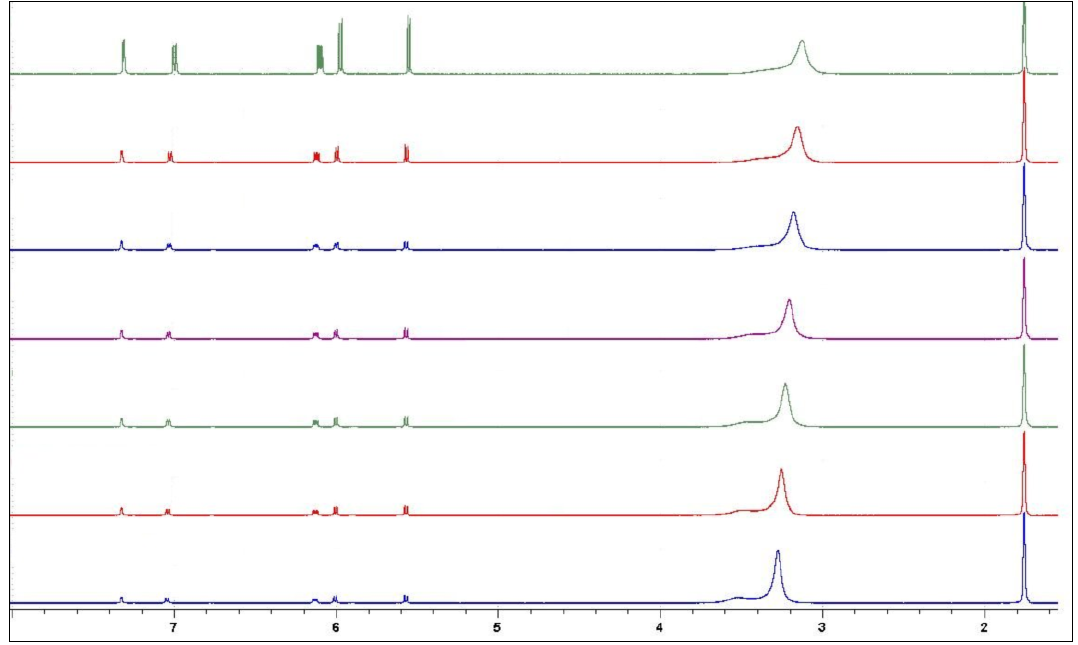
Figure 6. Variable temperature 500 MHz 1 H-NMR spectra of 1.0% 5-chloro-8-hydroxy- quinoline in CD OD/D O (2:1) from +18 °C (bottom) to +30 °C (top) in 2 °C steps. The 3 2 clear increase in the signal intensity between +28 °C and +30 °C is due to the gel-to-sol